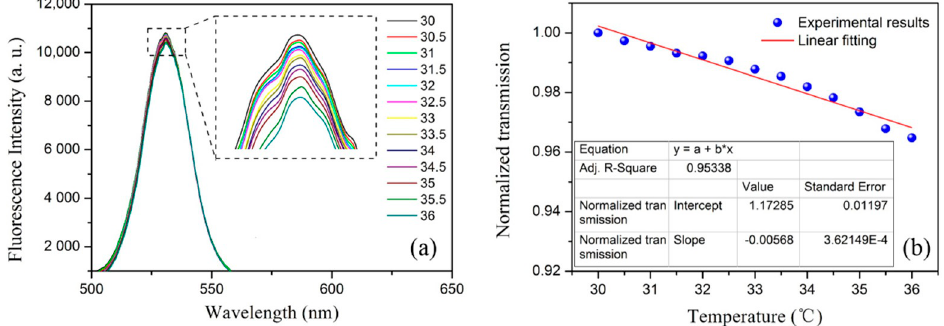
Figure 6. ( a ) The evolution of the QDs’ fluorescence spectra under different temperatures. ( b ) The normalized fluorescence intensity as a function of temperature.